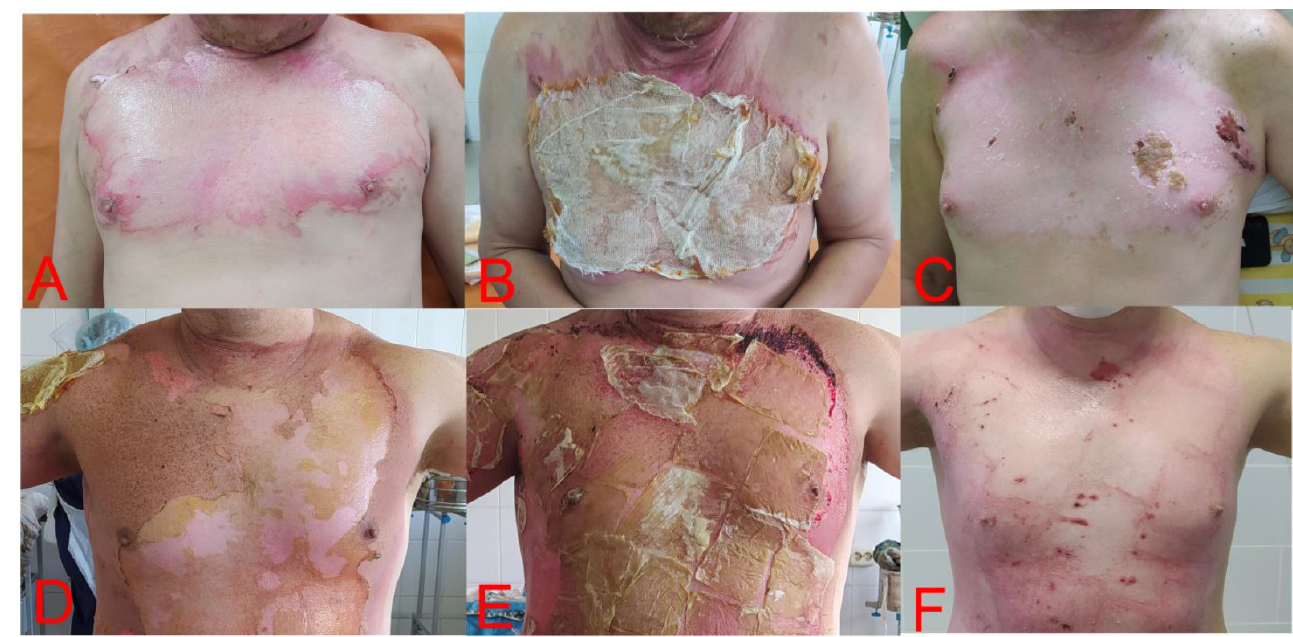
Figure 2. Participants of each group of study. ( A ) Patient of control group on the 1st day of trial, with 2A stage burns of anterior chest wall with boiled water, after debridement. ( B ) The same patient on the 3rd day of trial, and gauze bandages have adhered. ( C ) The same patient on the 14th day after discharge (20th day of trial). Re-epithelization of wound surface, with part of residual wound scab on the left side. ( D ) Test group patient on the 1st day of trial, with 2A stage burns of anterior chest wall with flame. ( E ) The same patient on the 3rd day of trial and total adherence of DBP, with drying. ( F ) The same patient on the 14th day after discharge (18th day of trial). Re-epithelization of wound surface. With small parts of residual wound scab on periphery of wound surface.